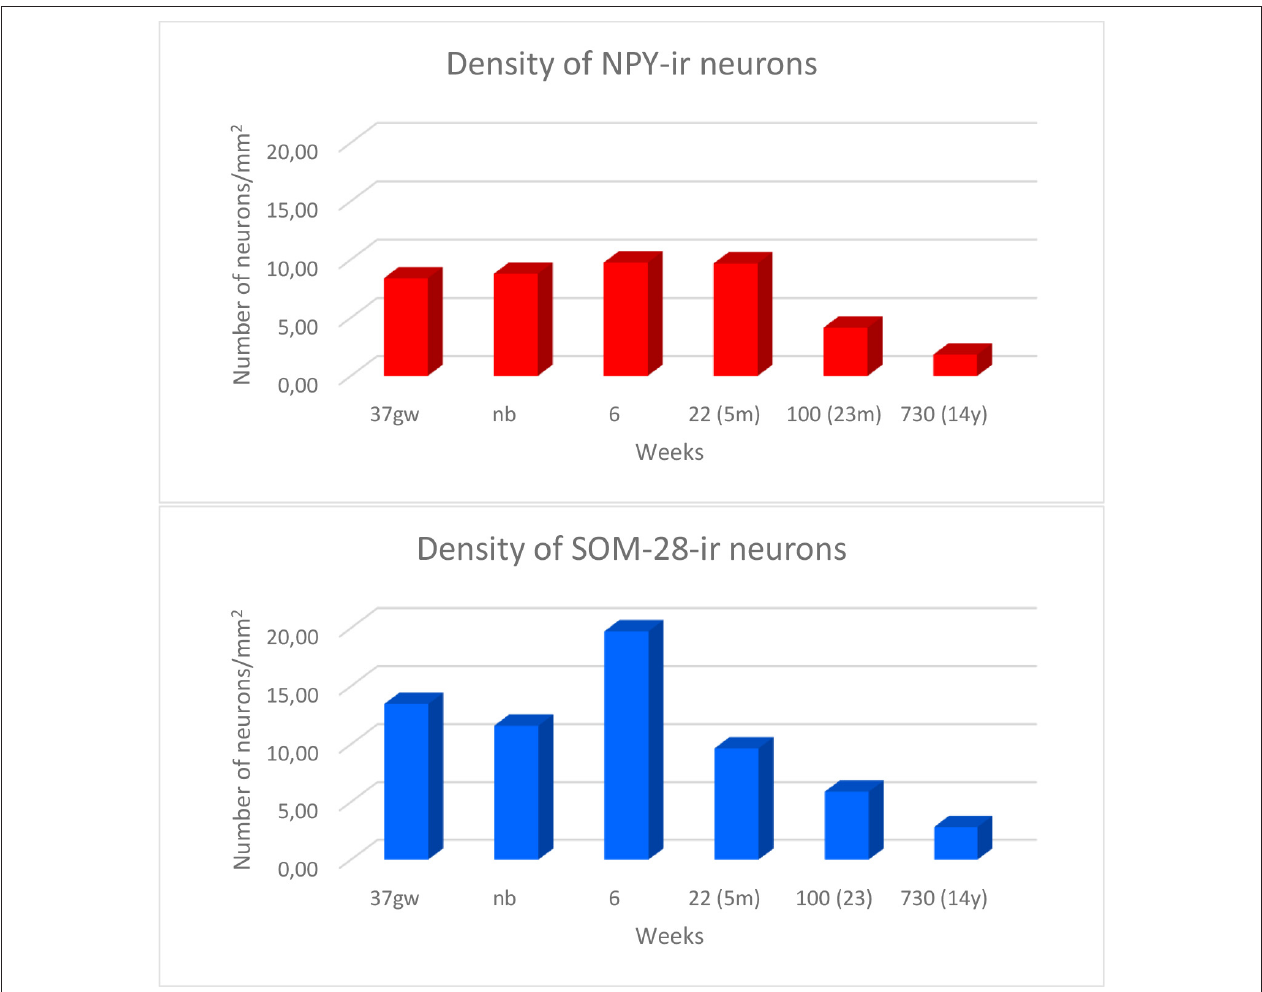
FIGURE 2 | Density of NPY- (in red) and somatostatin-28 (SOM-28)- (in blue) immunoreactive neurons expressed as units per square millimeter across different ages as determined at midlevel of the angular